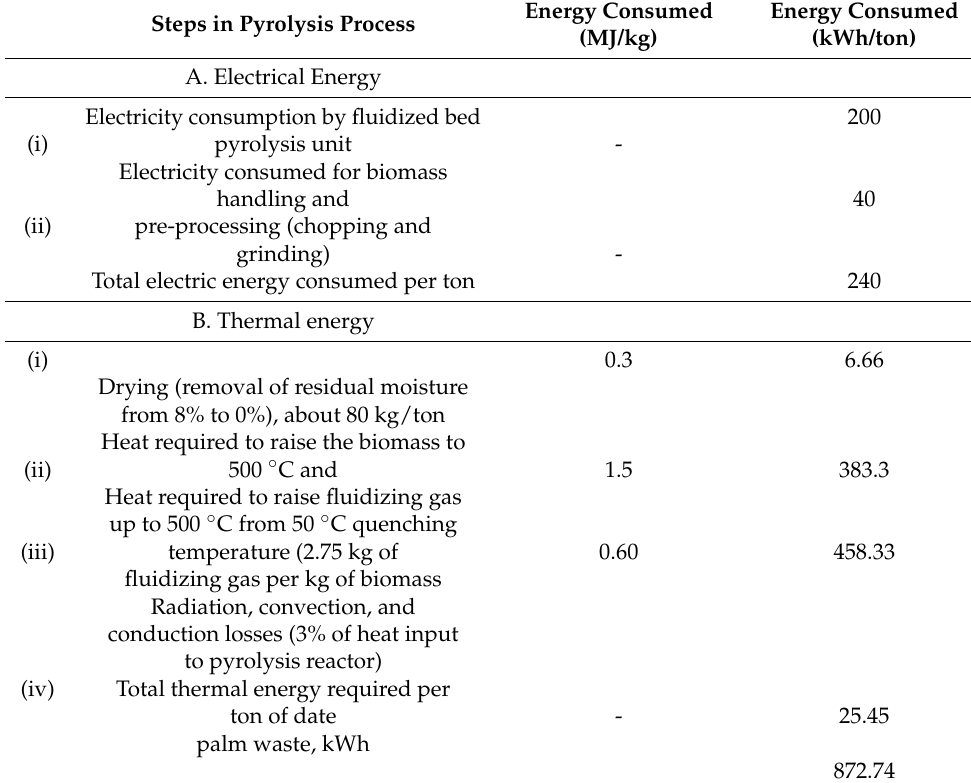
Table 10. Energy consumption in the pyrolysis process